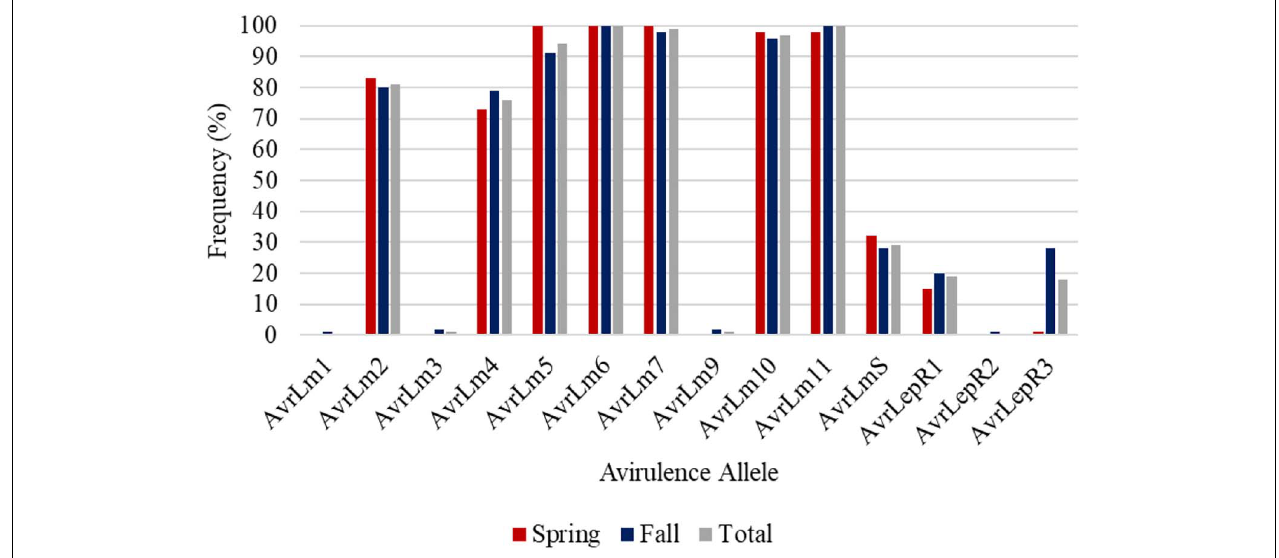
FIGURE 5 | Frequency of avirulence alleles in 254 L. maculans isolates collected in Manitoba from 2018 to 2019, assessed for 14 avirulence alleles from spring and fall collections.